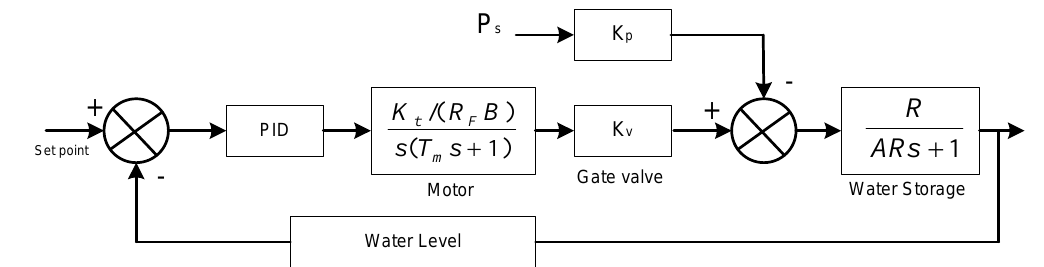
Figure 11. Water pump control system block diagram.